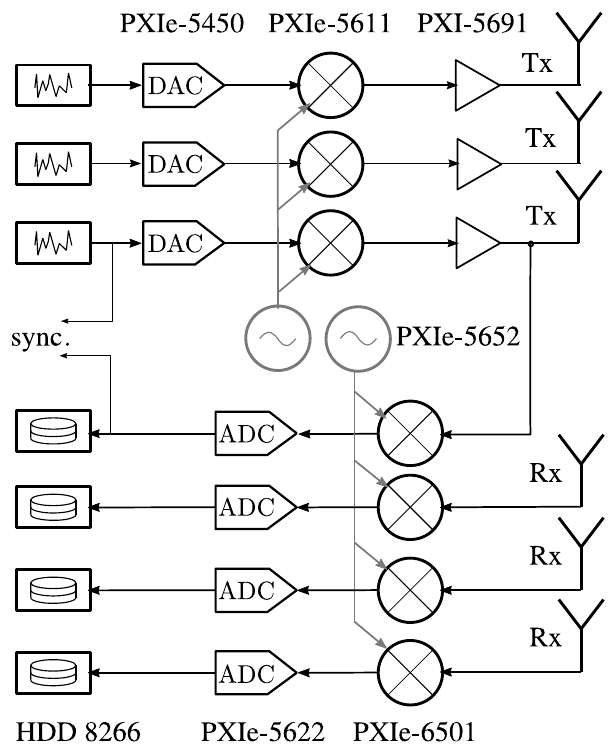
Figure 10. The diagram of the demonstrator system.